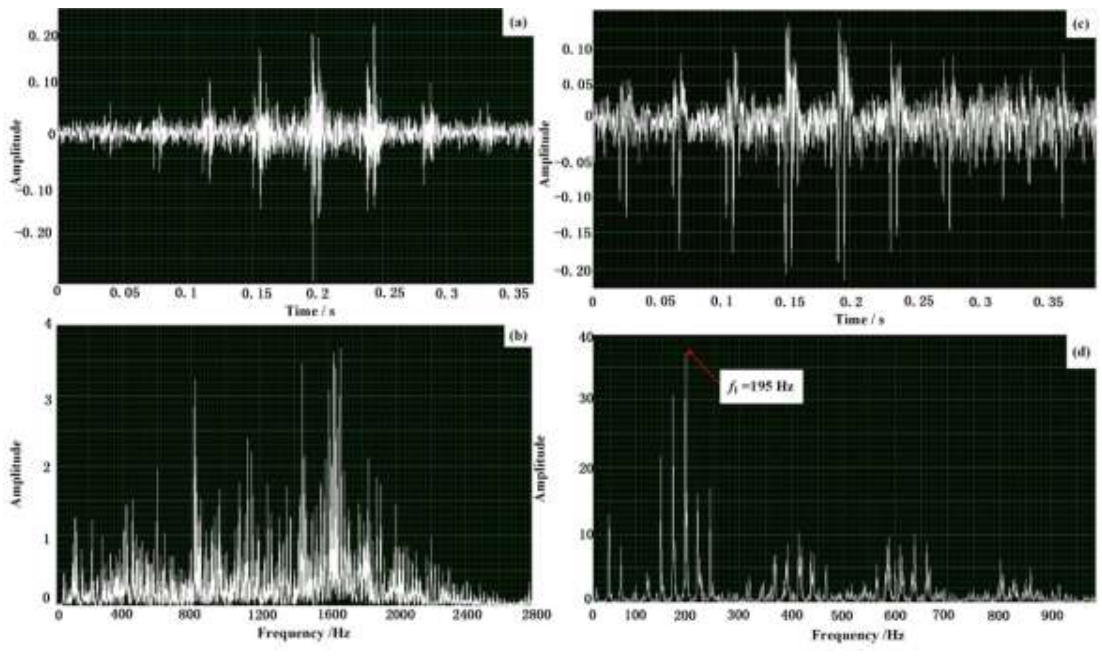
Figure 16. Effectiveness verification via the designed embedded system: ( a , b ) the waveform and the spectrum of the input Doppler distorted signal of the defective train bearing with a defect on the inner-race; ( c , d ) the waveform and the spectrum of the output restored envelope signal via the designed embedded